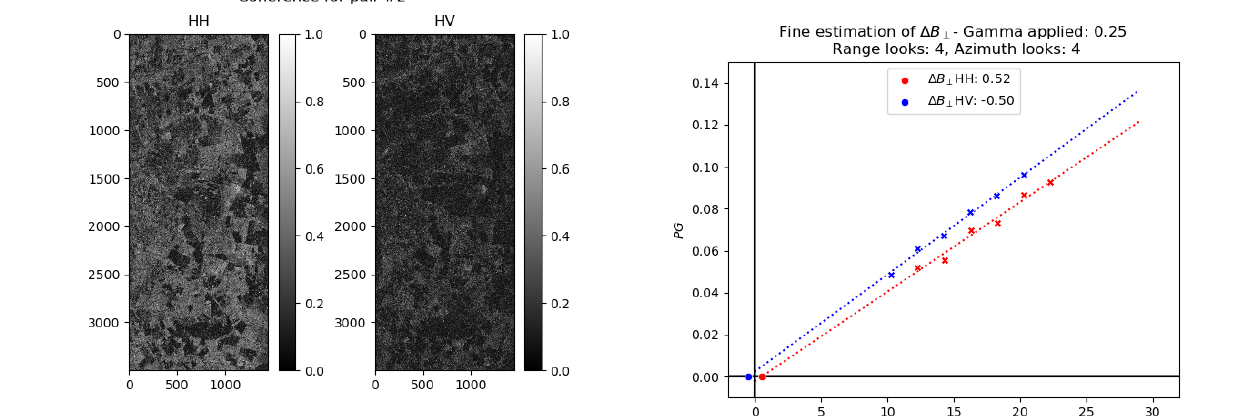
Figure 11. Fine estimation of ∆ B ⊥ from HH and HV data in pair